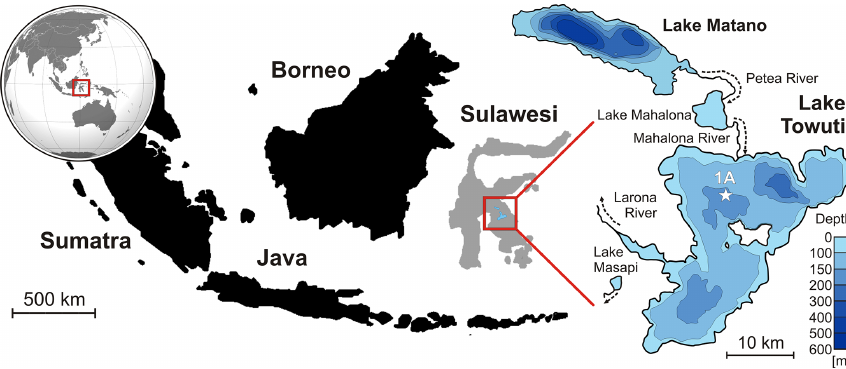
Figure 1. Location of the Malili Lake System and a bathymetric map of Lake Matano and Lake Towuti. World map displaying the location of Sulawesi (inset; red square) with a close-up of the Indonesian archipelago and location of the Malili Lake System (red square in main map). On the right is a bathymetric map of Lake Matano and Lake Towuti with the position of the ICDP drilling site TDP-1A from which hydraulic piston cores were retrieved and sampled for this